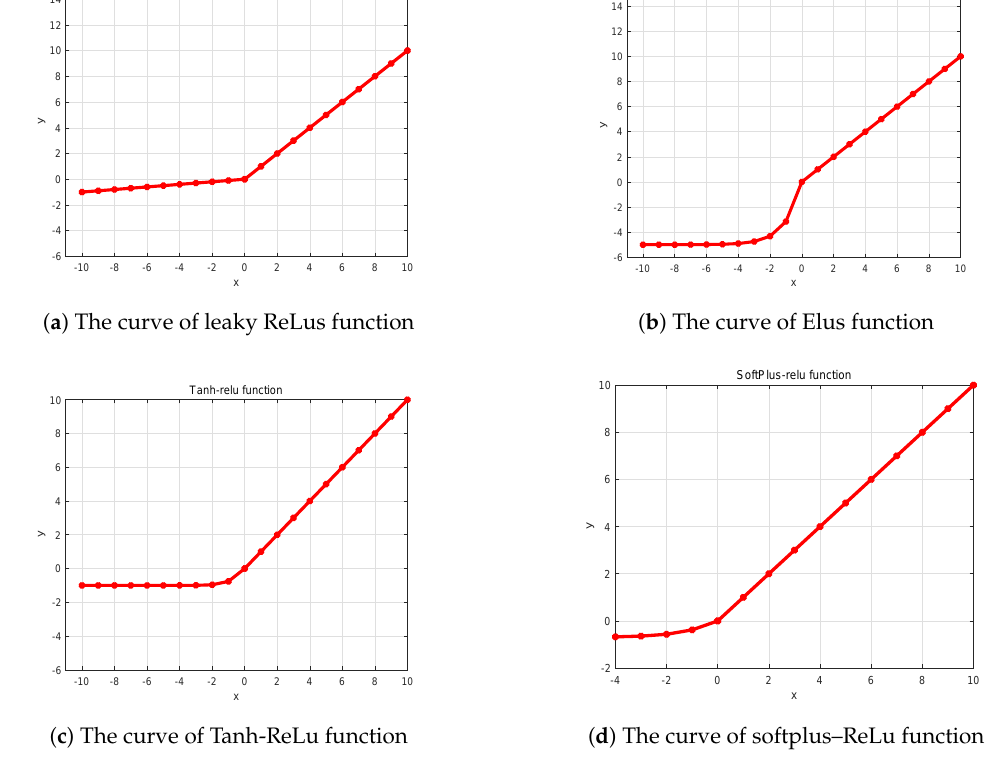
Figure 5. The curves of variant functions based on the ReLu